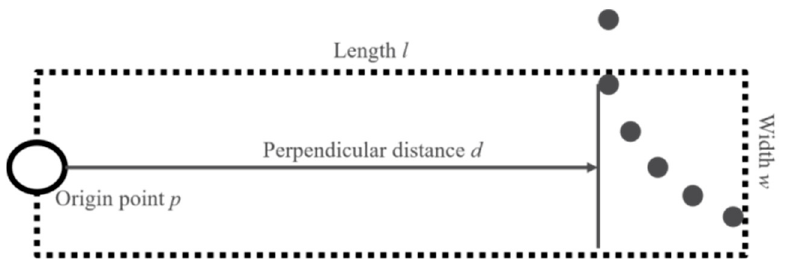
Figure 2. Concept of a Reference Point. Origin p is the point to which the distance of a vessel is calculated. A filter box is marked by dotted lines, which is defined by a length l and a width w . Starting from the point, the perpendicular distance to a ship is calculated, which is marked by a point cloud (black dots).